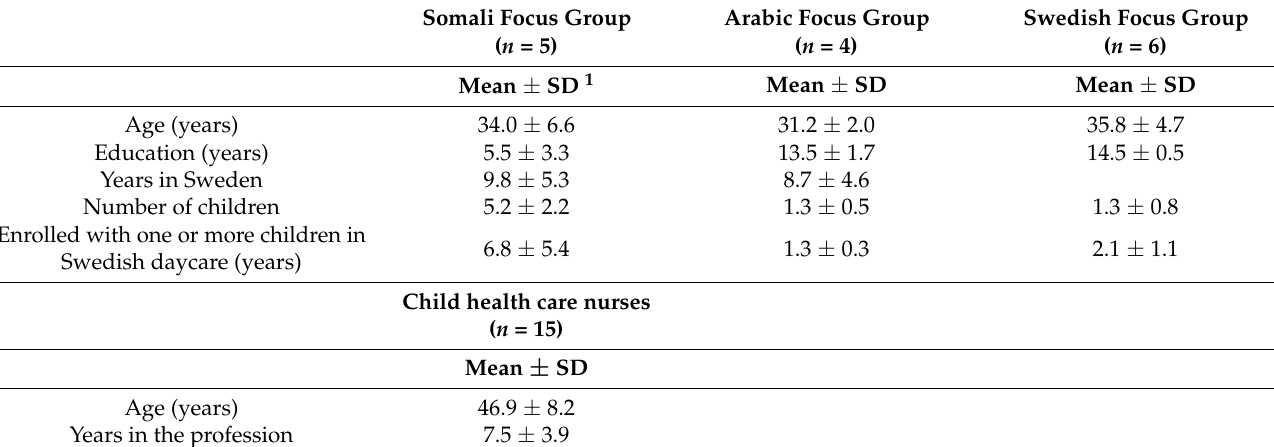
Table 1. Characteristics of participating parents * and child health care nurses.